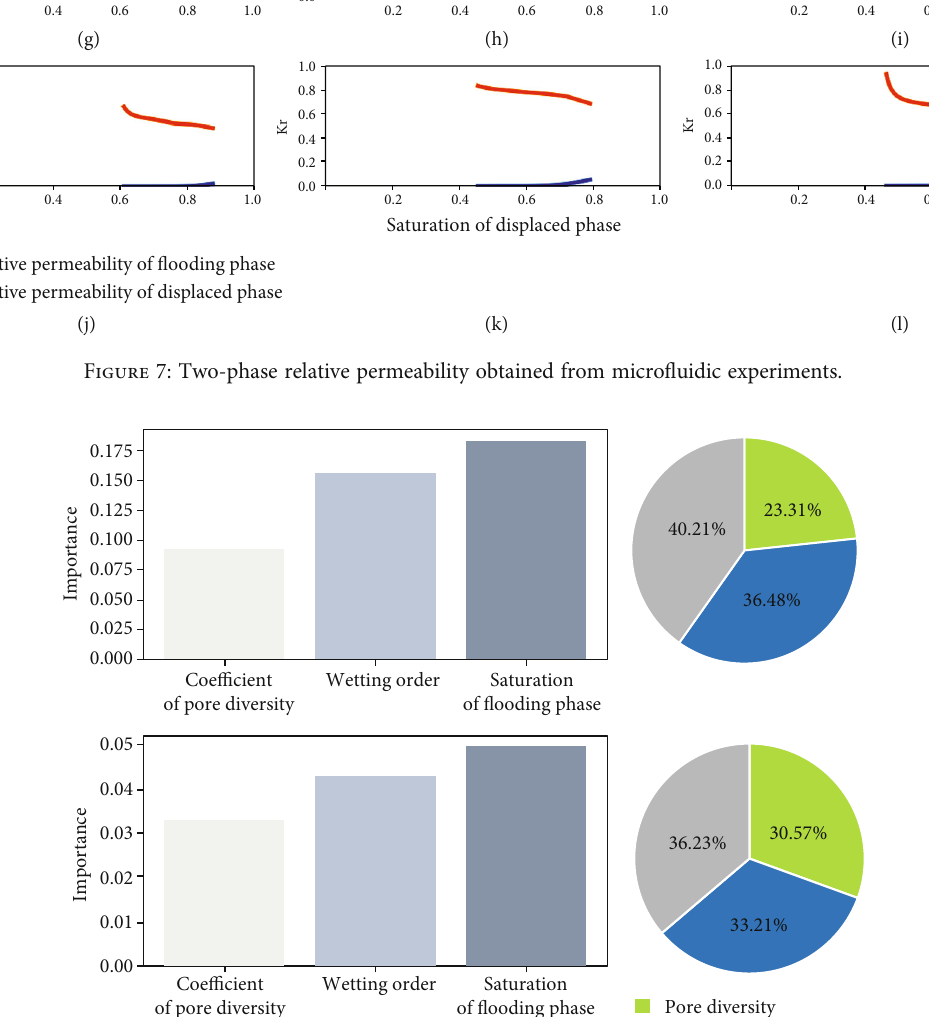
Figure 8: Sobol sensitivity analysis of saturation, wetting order, and pore diversity impact on relative